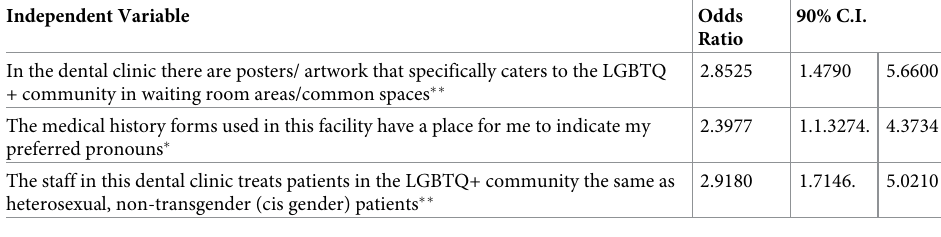
Independent Variable Odds